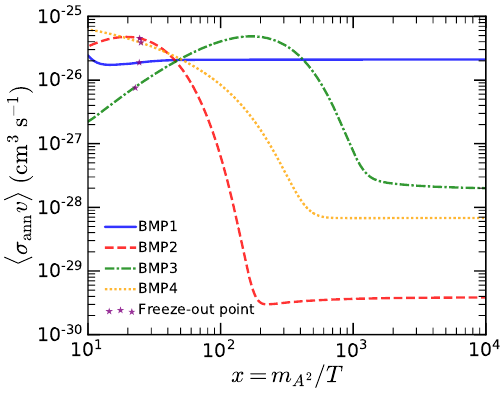
/T for four bench- A 2